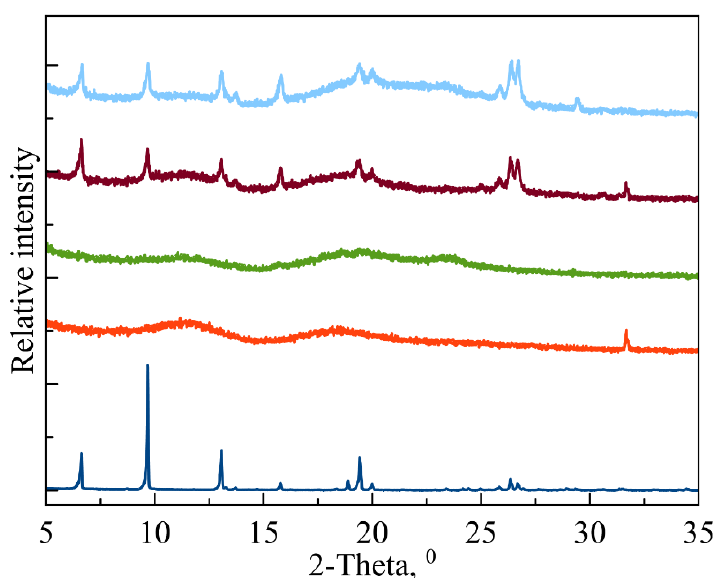
Figure 3. Experimental PXRD patterns for LV (navy blue), MCD (red) and MCDpol (green); LV-MCD (brown) and LV-MCDpol complexes (baby blue). From 35° to 80°, no more signals were observed.